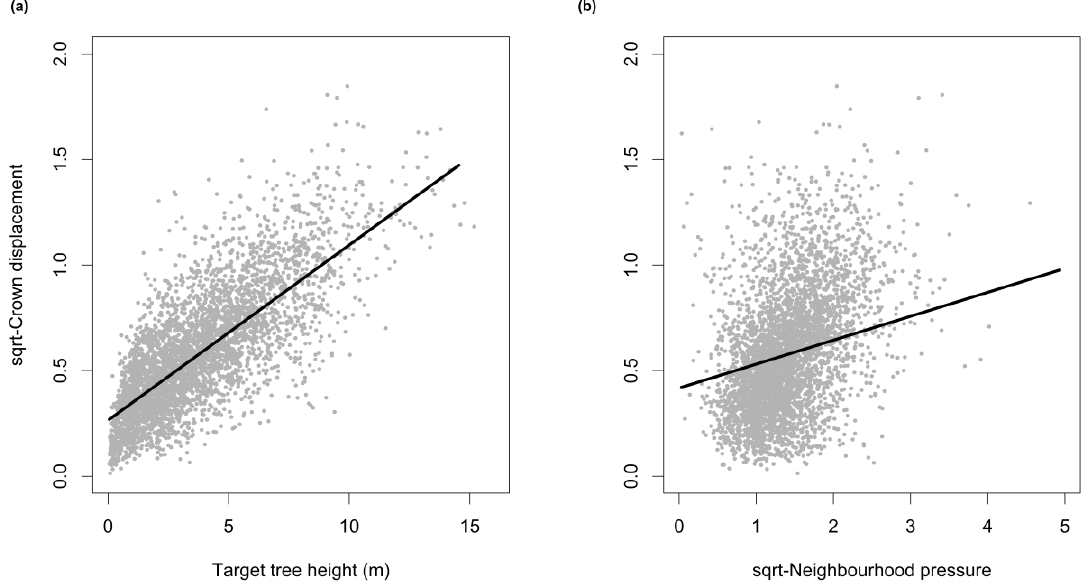
Figure 4. Differences in the strength of the effects of ( a ) target tree height and ( b ) neighbourhood pressure (square root-transformed) on crown displacement (square root-transformed). Lines represent mixed-effects model fits with microtopography and neighbourhood tree species richness kept at their means. Grey points represent observed values.